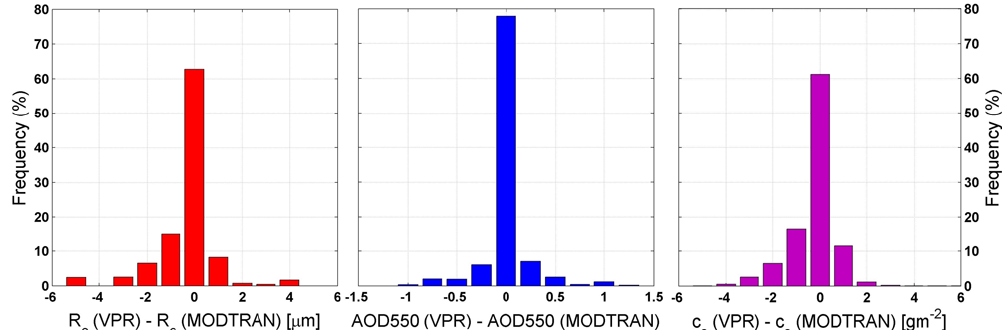
Fig. 7. Frequency (%) of the differences VPR-MODTRAN (MODIS-Terra) for R e (left), AOD550 (middle), and c s